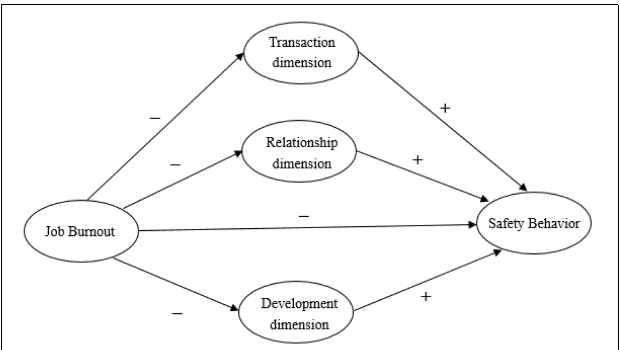
FIGURE 1 | Research hypothesis model